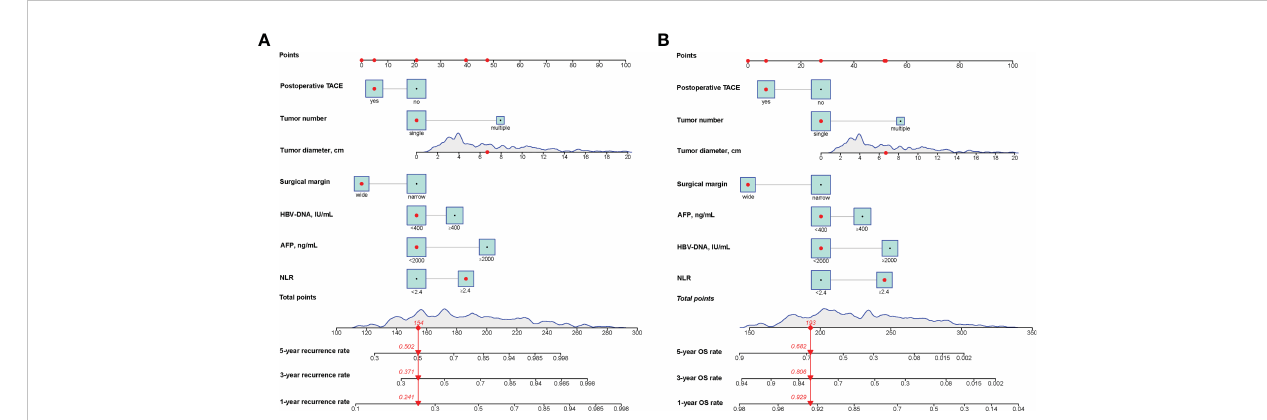
FIGURE 1 Nomograms for predicting the 1-, 3- and 5-year recurrence (A) and OS (B) rates in patients with HBV-HCC with MVI. OS, overall survival; HCC, hepatocellular carcinoma; NLR, neutrophilto-lymphocyte ratio; TACE, transcatheter arterial chemoembolisation; AFP, alpha-fetoprotein; HBV-DNA, HBV deoxyribonucleic acid.